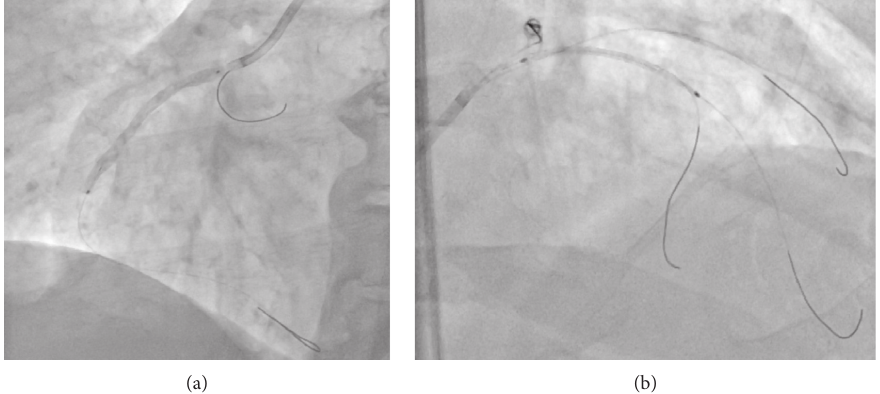
Figure 3: (a) LAO cranial view showing the wire over the aorta to mark the RCA ostium and ostial positioning of stent. Note. The loop is created in the wire at RPDA. (b) Stent positioned in LAD according to the marker wires at septal, diagonal, and LCX.